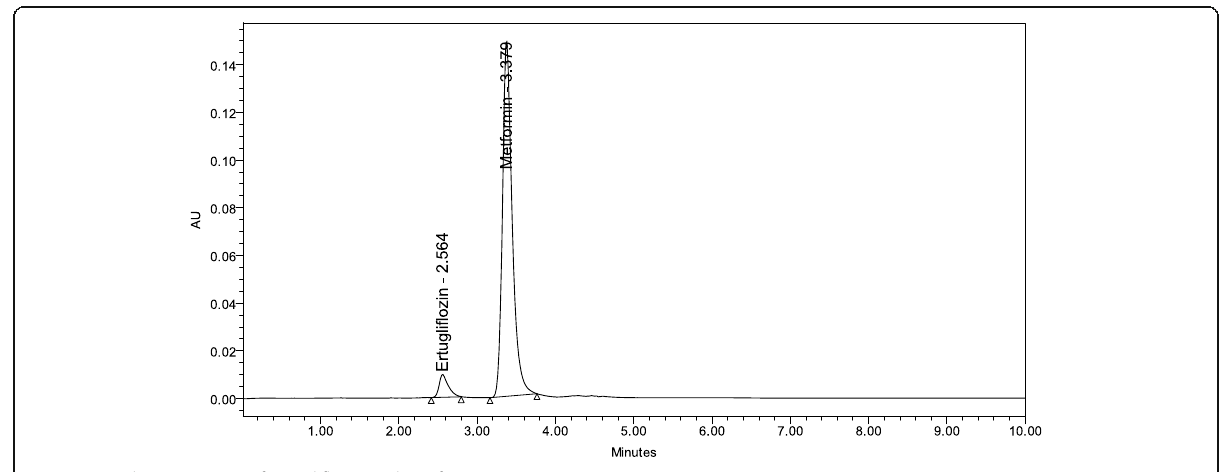
Fig. 10 UV chromatogram of Ertugliflozin and Metformin